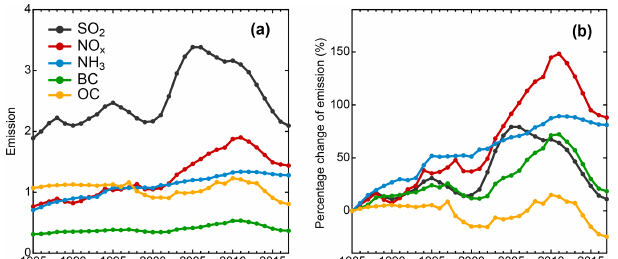
Figure 1. (a) Variations in total emissions (anthropogenic plus nat- ural emissions) of sulfur dioxide (SO 2 , TgSDJF − 1 ), nitrogen ox- ide (NO x , TgNDJF − 1 ), ammonia (NH 3 , TgNDJF − 1 ), black car- bon (BC, TgCDJF − 1 ), and organic carbon (OC, TgCDJF − 1 ) over eastern China (105–123 ◦ E, 20–45 ◦ N) during December–January– February (DJF) from 1985 to 2017 and (b) the percentage changes relative to 1985